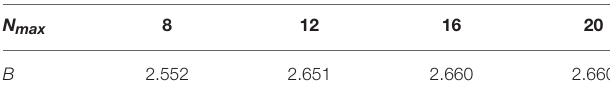
TABLE 11 | The 3 3 H binding energy B (in MeV) as function of N max , calculated with the the Gaussian potential model of Clare and Levinger [18], using G max 20, j max 8, and γ 4 fm − 1 = = =